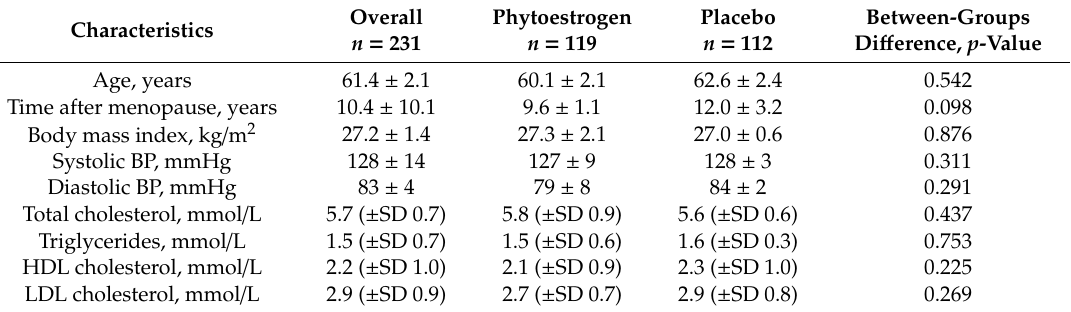
Table 2. Clinical and laboratory data of late postmenopausal study participants at baseline.